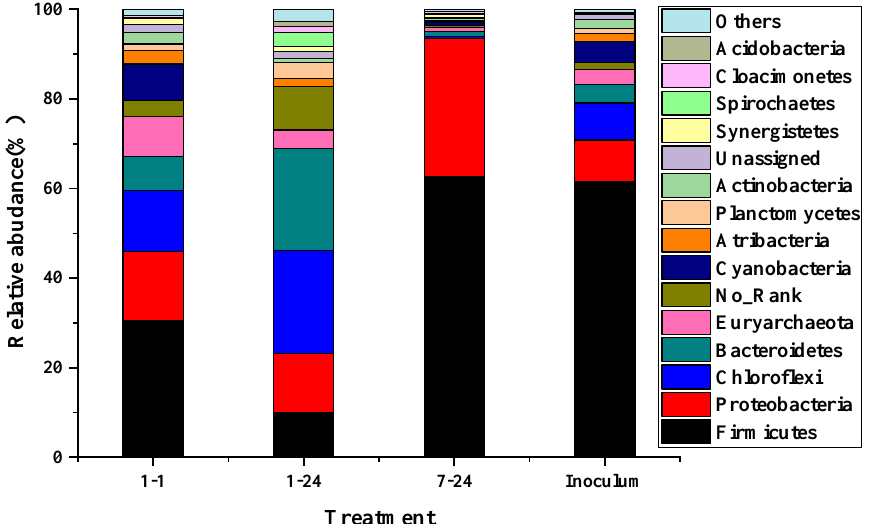
Figure 7. Relative abundances of phylum in each sample; 1–1 represents for particle 1 group at 1 h hydrolysis time; 1–24, 7–24 represents particle 1 group and particle 4 group at 24 h hydrolysis time, respectively; inoculum represents the aerobic inoculum.